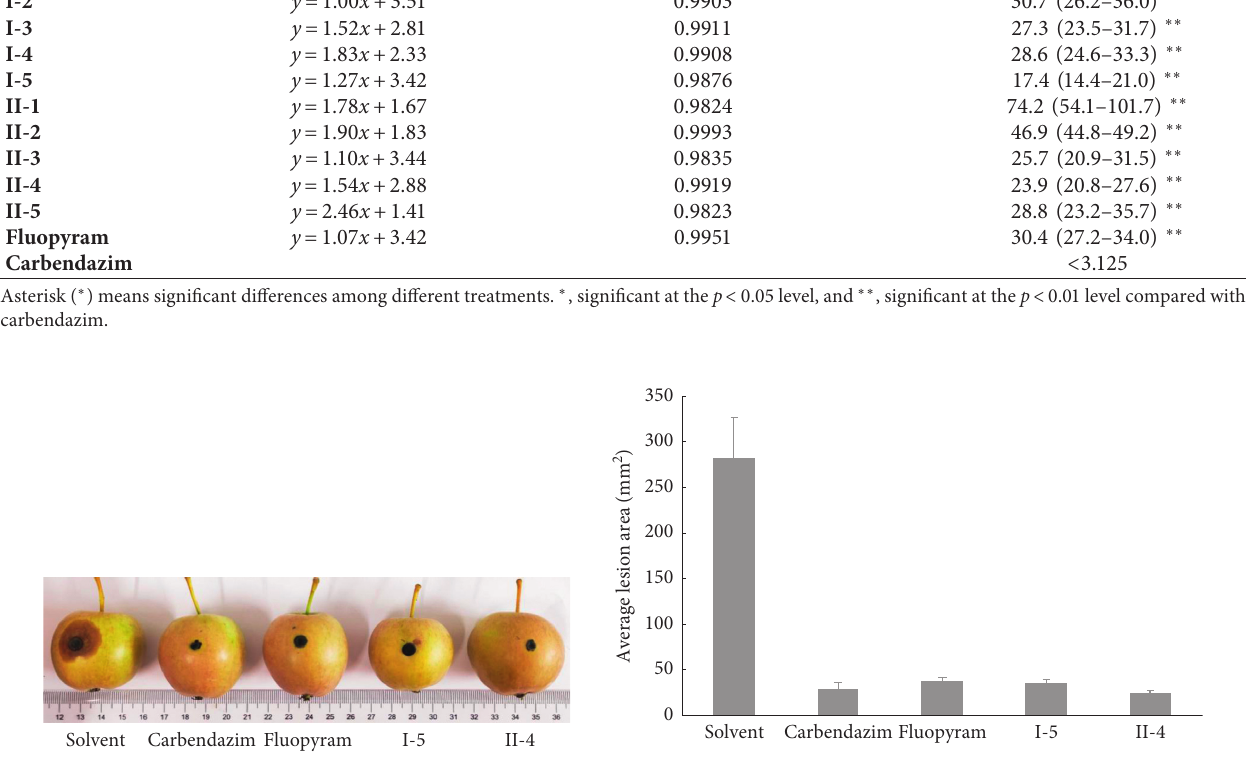
Table 4: Medium effective concentration ( EC Compounds